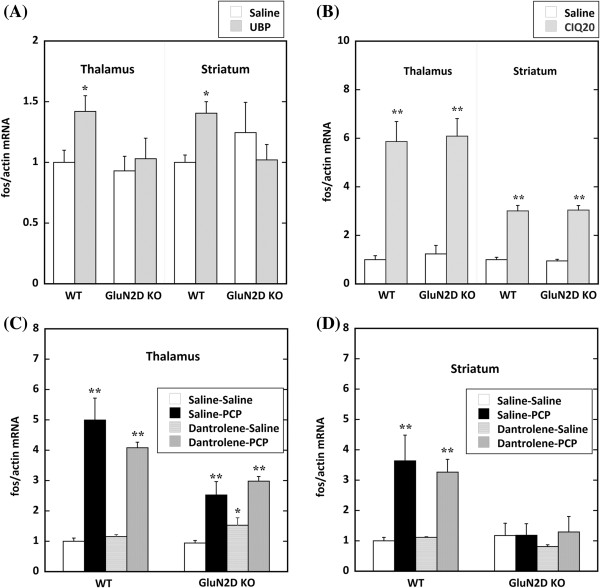
Quantitative RT-PCR demonstrated the transcription of c-fos expression in the thalamus and striatum. The ratio of c-fos/actin transcripts is expressed as the mean ± SEM fold change from saline controls in WT mice. (A) Two hours after the injection of UBP141 (3 mM, 20 μl, i.c.), a significant increase in c-fos mRNA was observed in the thalamus and striatum in WT but not KO mice (*p < 0.05). (B) CIQ (20 mg/kg, i.p.) markedly increased c-fos mRNA expression in the thalamus and striatum in WT and KO mice (**p < 0.01). No genotype difference was found between WT and KO mice. (C) PCP (10 mg/kg, s.c.) significantly increased c-fos mRNA expression in the thalamus with or without dantrolene (**p < 0.01), which completely suppressed PCP-induced hyperlocomotion. In the thalamus, dantrolene (5 mg/kg, i.p.) itself induced the slight activation of c-fos expression in GluN2D KO mice (*p < 0.05). (D) PCP (10 mg/kg, s.c.) significantly increased c-fos mRNA expression in the striatum in WT mice with or without dantrolene, but PCP had no effect in the striatum in GluN2D KO mice.